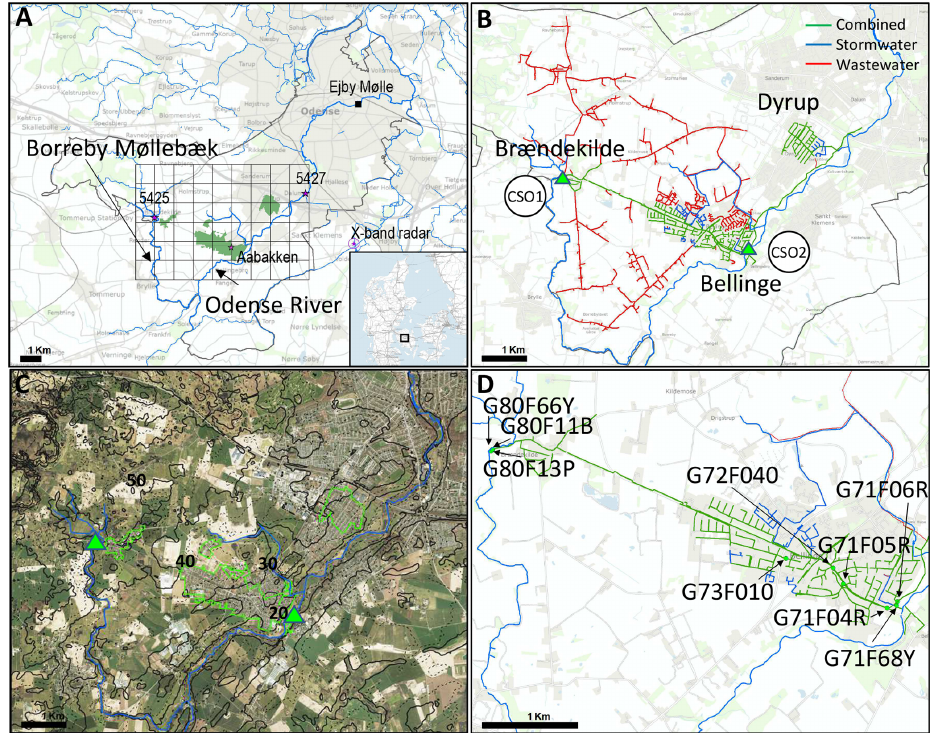
Figure 1. Maps of the case area, indicating rivers as blue lines. (a) Locations of Brændekilde, Bellinge and Dyrup (dark green areas) in the upstream part of the sewer catchment of Ejby Mølle WRRF (black outline); locations of rain gauges (stars); and locations of X-band radar grid cells (grid). (b) The pipe network in the area, distinguishing combined sewers (green) from separate sewers for stormwater (blue) and wastewater (red). Combined sewer overflow locations (green triangles). (c) Orthophoto of the area along with contour lines, indicating combined sewer overflow locations (green triangles). (d) Locations of the in-sewer sensors in Brændekilde and Bellinge together with the combined and stormwater system (wastewater pipes are hidden for simplicity). Background maps provided by DADSE